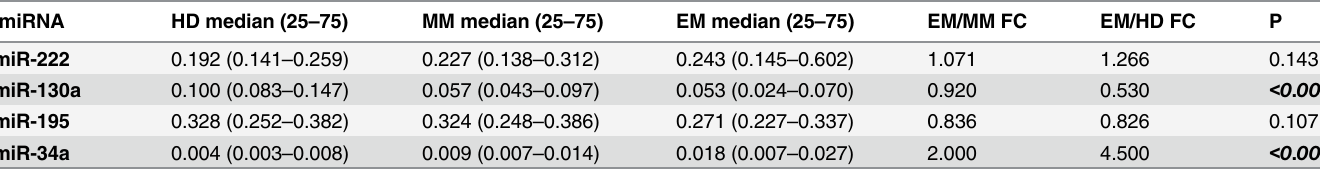
Table 2. MiRNA levels in a test cohort of patients. Data are presented as a median of normalized miRNA expression and interquartile range. Kruskal-Wal- lis test was used to compare the values. Fold change (FC) between extramedullary myeloma (EM) patients versus newly diagnosed multiple myeloma patients (EM/MM) and extramedullary myeloma patients versus healthy donors (EM/HD), and p values are presented. Significant values p < 0.05 are marked with bold and italics.